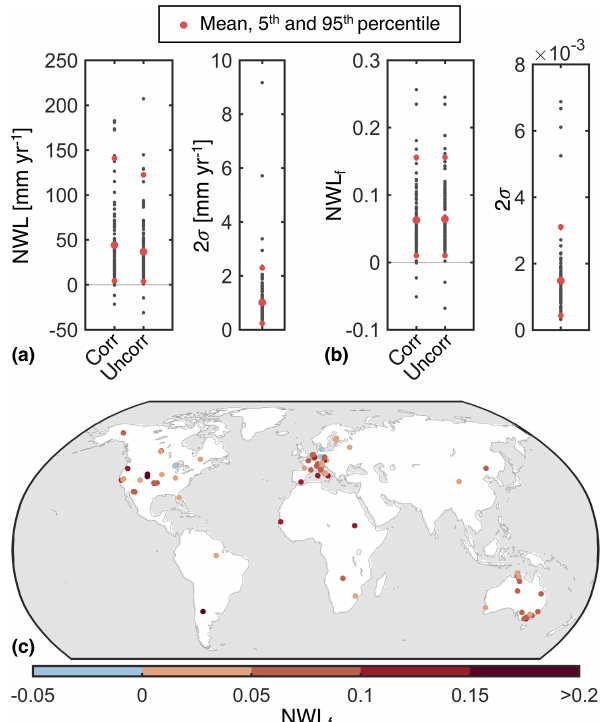
Figure 2. Nocturnal water loss (NWL) at 99 FLUXNET sites as the annual NWL (a) and as the fraction of total evapotranspira- tion NWL f (b) . Values from individual sites are shown in black, whereas the mean, 5th percentile, and 95th percentile are shown in red. Both energy-balance-corrected values (Corr) and uncorrected values (Uncorr) are shown. Uncertainty estimates are given by 2 σ , which correspond to a confidence interval of approximately 95%. The uncertainty of total ET is small and, therefore, neglected when computing the uncertainty of NWL f . (c) The location of sites with their estimated NWL f